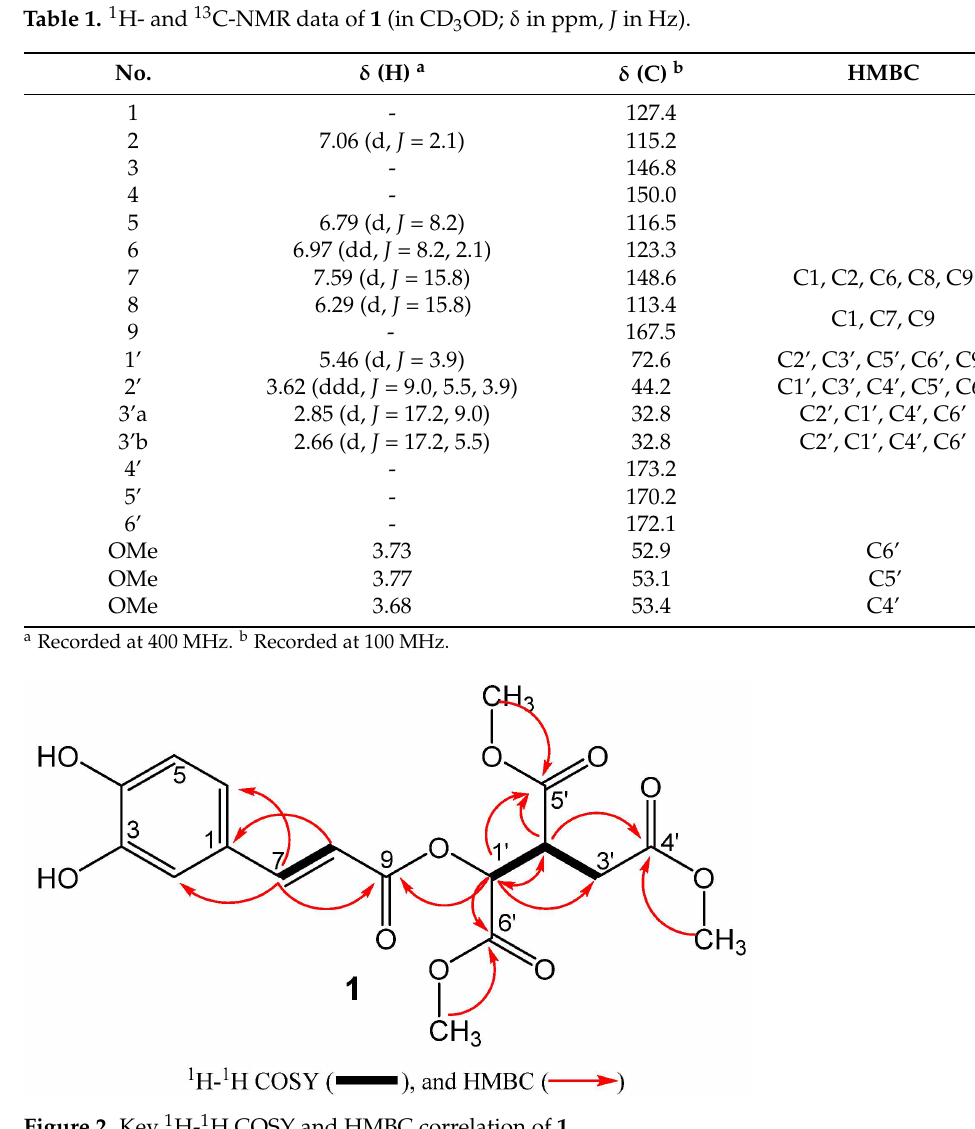
Figure 2. Key 1 H- 1 H COSY and HMBC correlation of 1